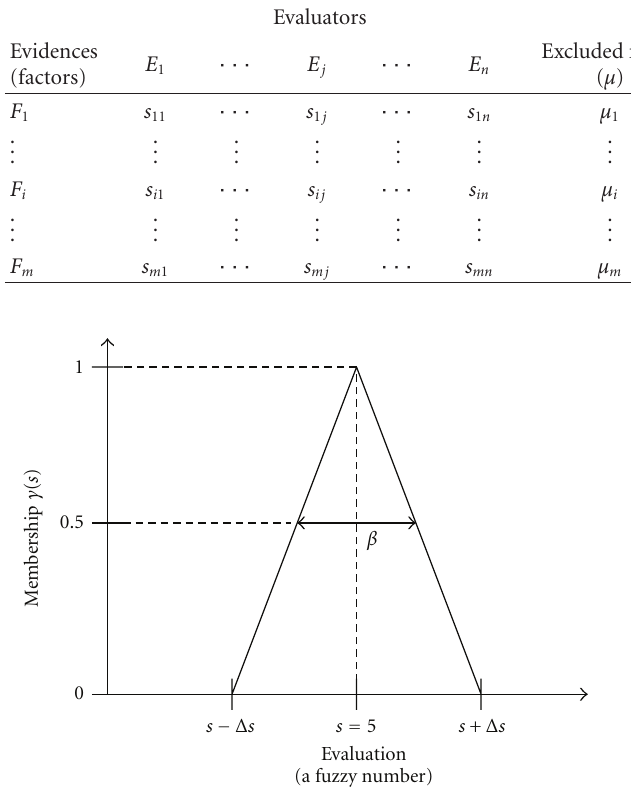
Figure 1: A triangular membership function ( γ ∈ [0,1]) for a fuzzy number (evaluation) s = 5. At the membership γ = 0 . 5, the width β = Δ s of the triangular membership function represents the measure of uncertainty associated with the fuzzy number s